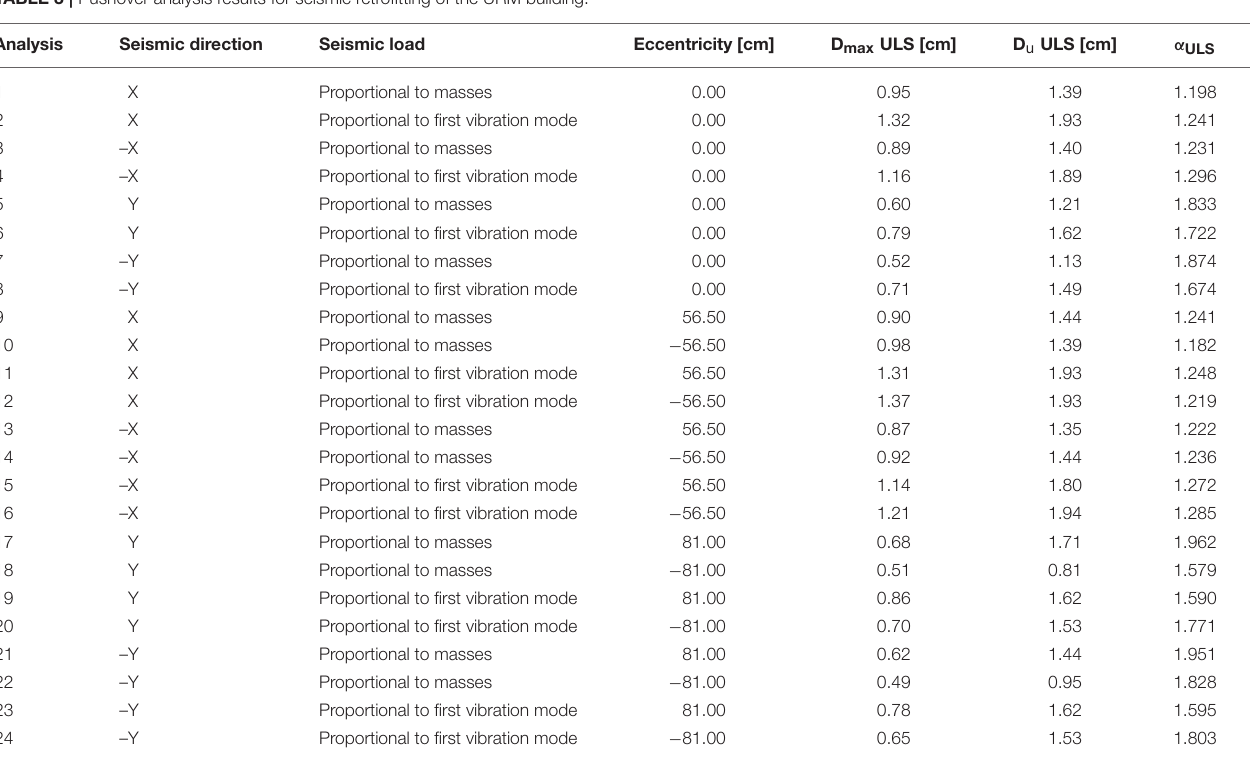
TABLE 3 | Pushover analysis results for seismic retrofitting of the URM building.